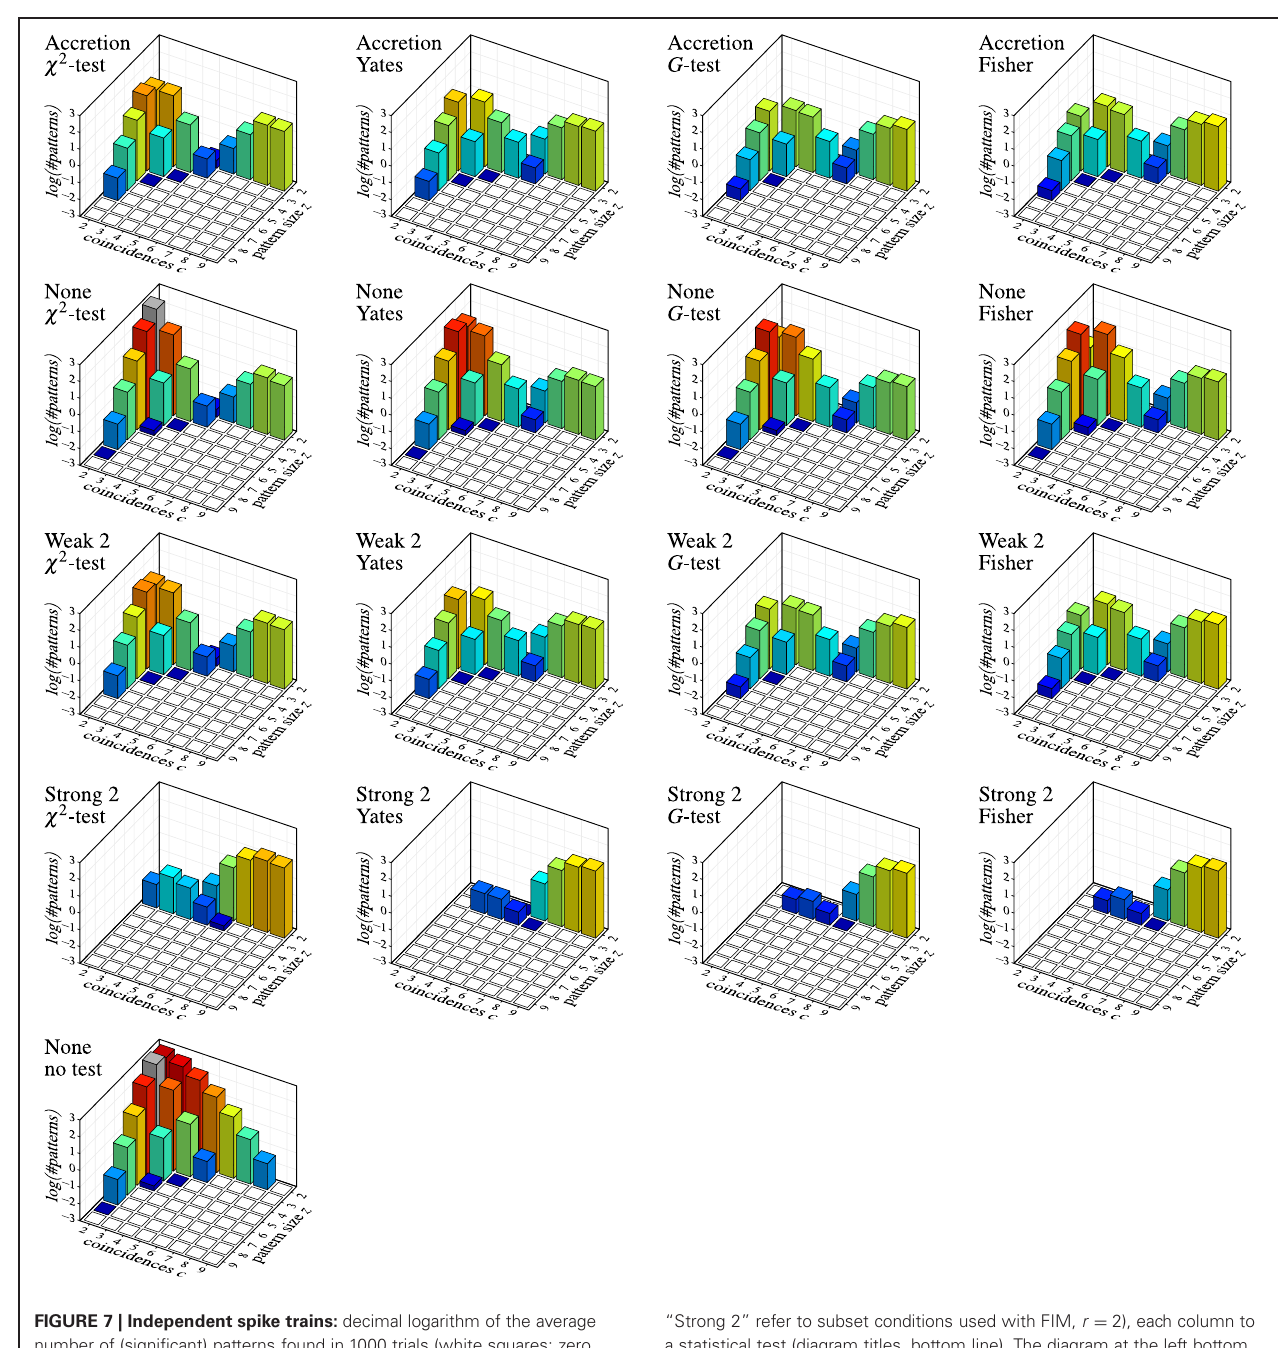
FIGURE 7 | Independent spike trains: decimal logarithm of the average number of (significant) patterns found in 1000 trials (white squares: zero patterns, gray bars: higher than chart). Each row of the chart grid corresponds to a detection method (diagram titles, top line; “None”, “Weak 2” and